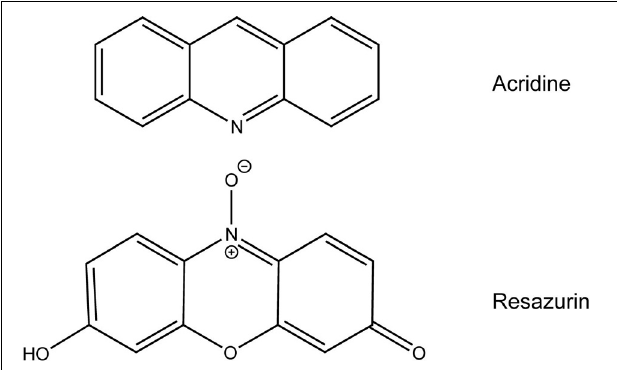
FIGURE 5 | Chemical structures of resazurin and